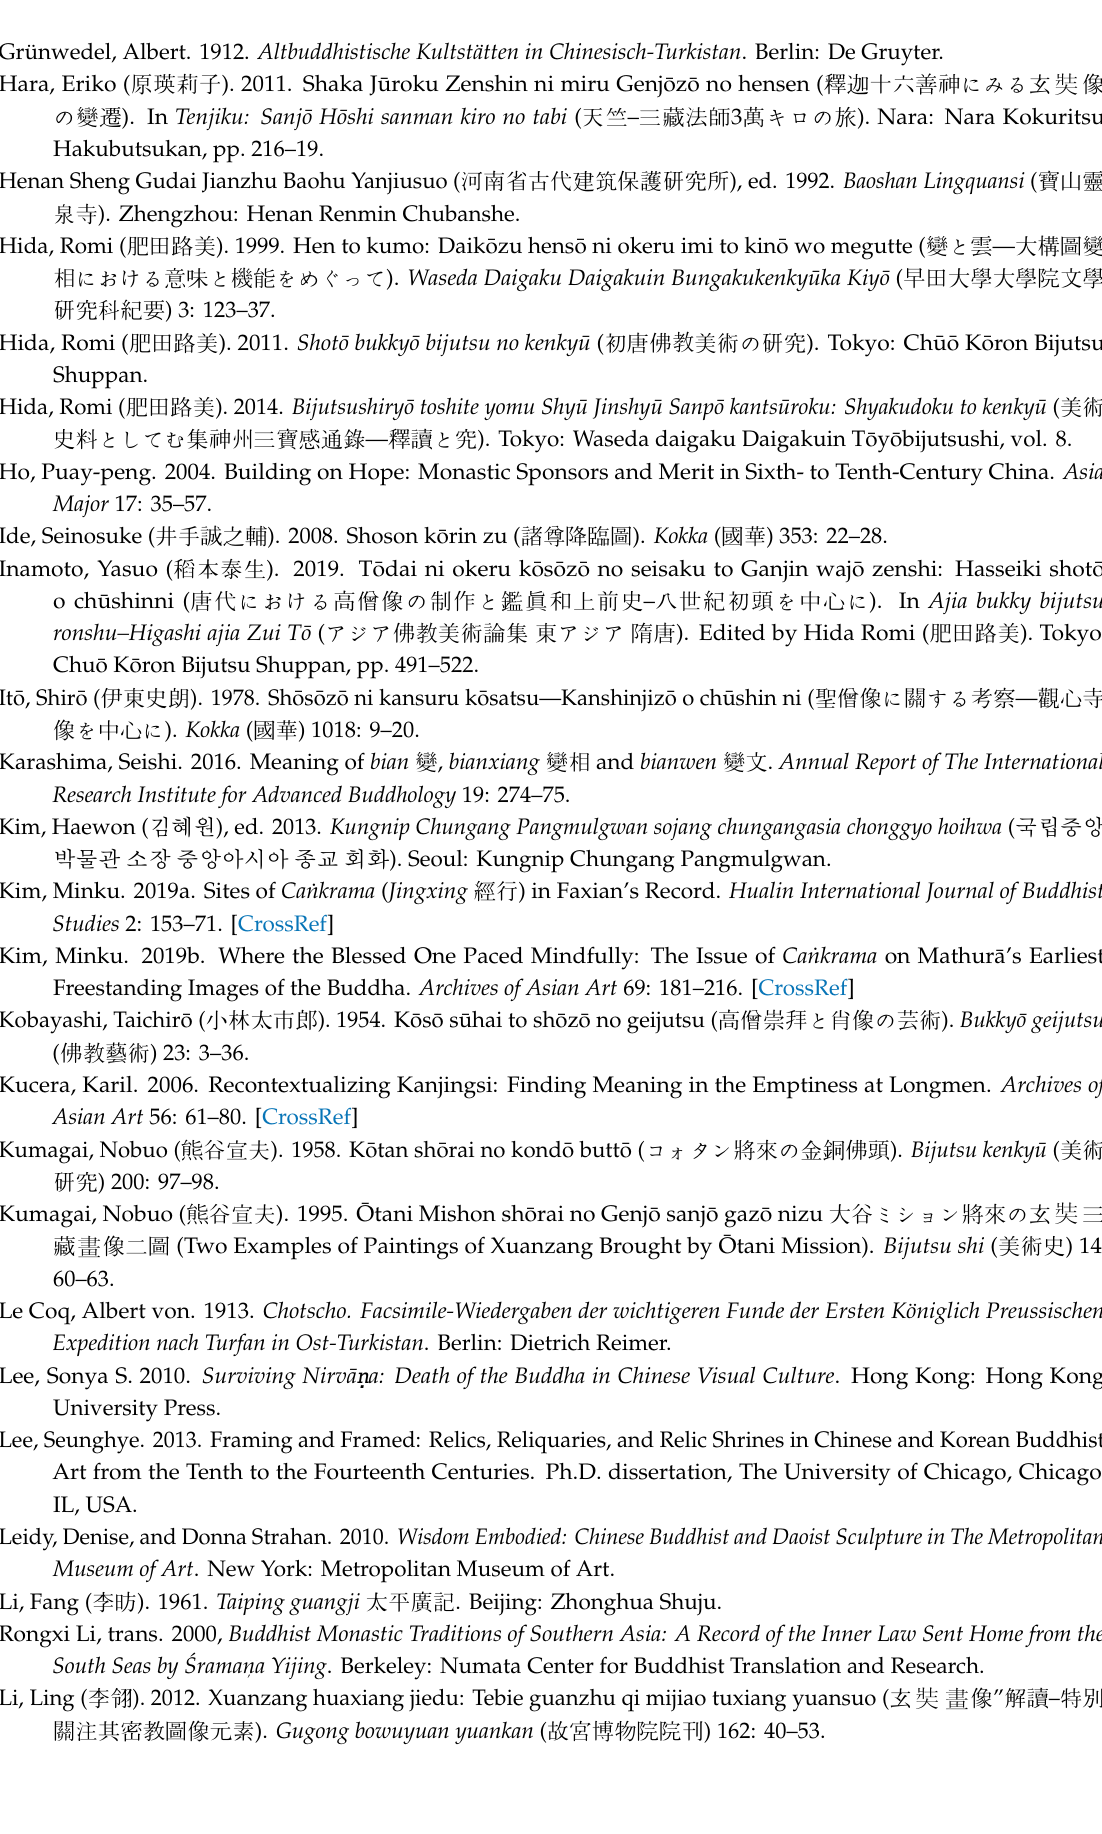
Figure 7. Itinerant Monk . Dunhuang, 10th century. Ink and colors on paper, 51.8 × 29. 3 cm. Inv. No. Dh-320. The State Hermitage Museum, St. Petersburg. Photograph © The State Hermitage Museum, Photo by Leonard